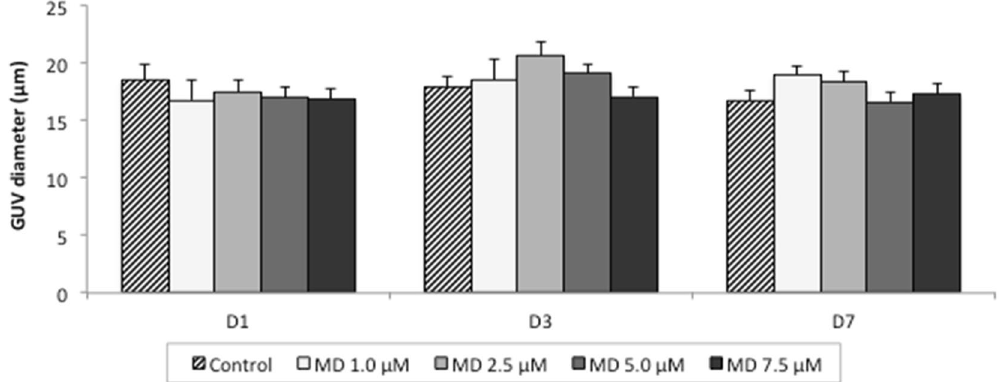
Figure 1. Diameter of giant unilamellar vesicles (GUVs) cultured in vitro with different concentrations of menadione (MD). Data are expressed as the mean ± standard error of three independent replicates (control, n = 147; MD 1.0 µM, n = 119; MD 2.5 µM, n = 134; MD 5.0 µM, n = 132; and MD 7.5 µM, n = 148). *D1 = day 1 (beginning of cultivation); D3 = day 3 (72-h cultivation); D7 = day 7 (168-h cultivation). No differences were observed between treatments within each assessment day ( P > 0.05).